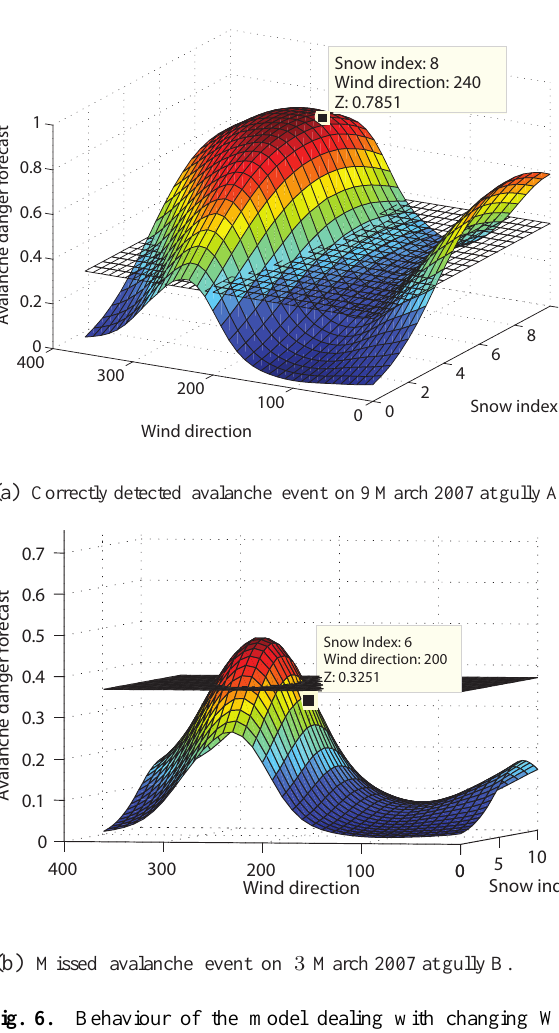
(b) Missed avalanche event on 3 March 2007 at gully B. Fig. 6. Behaviour of the model dealing with changing Wind direction and Snow index at the selected gullies. The decision threshold t is represented by the gridded black plane at a height of 0.37.